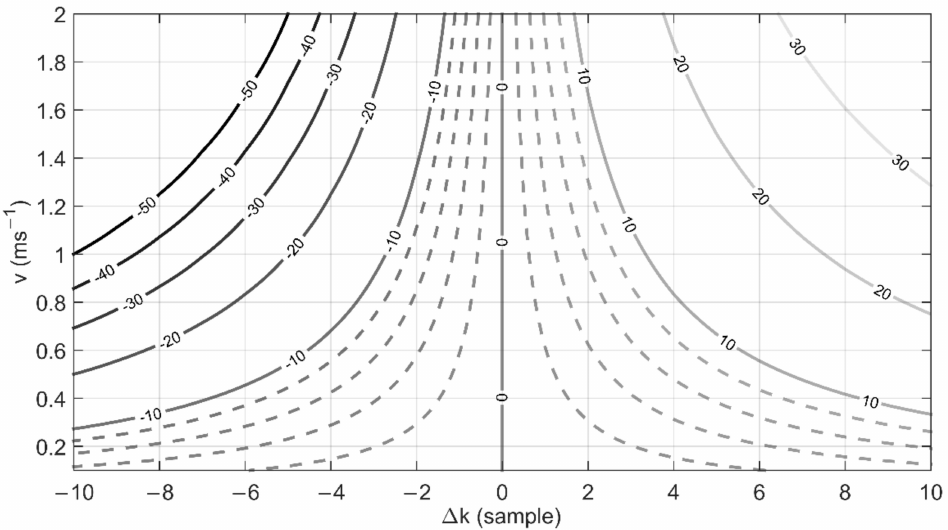
Figure 4. Relative error in determining the flow velocity as a function of the uncertainty of the line shift ∆ k and the set velocity v